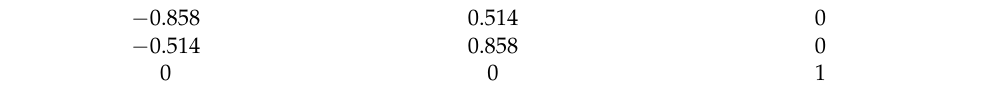
Table 5. Rotation matrix around the OZ axis, offset by the averaged rotation angle.